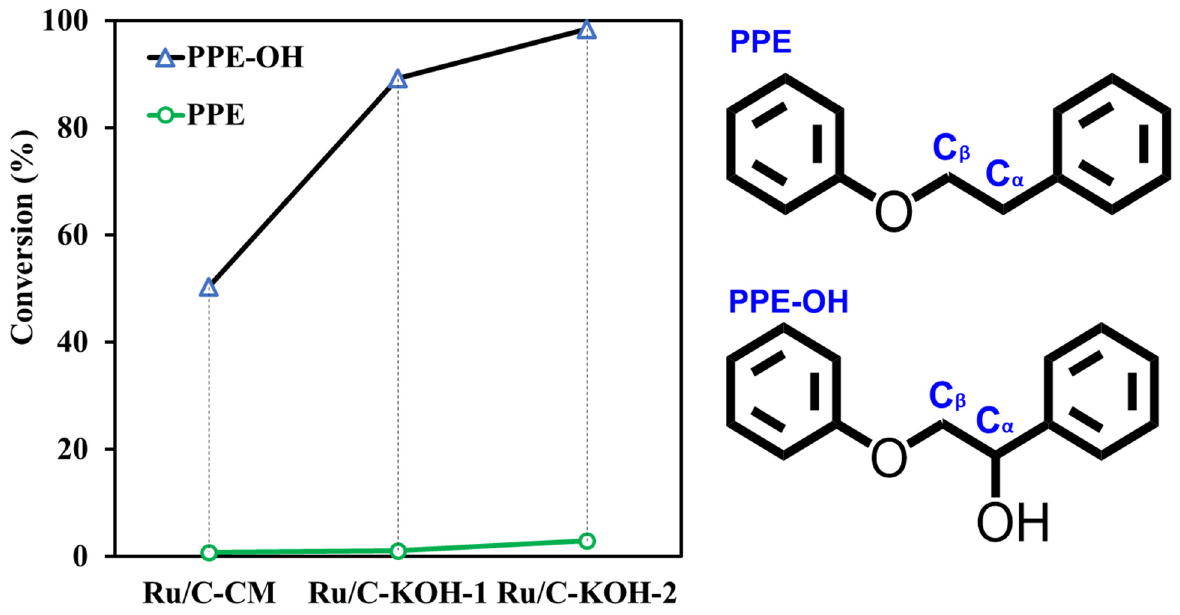
Figure 3. The conversion of 2-phenoxy-1-phenyl ethanol and 2-phenethyl phenyl ether over investigated Ru/C catalysts. Reaction conditions: 1 h, N 2 atmosphere, 1 wt.% reactant/ethanol, 20 wt.% catalyst loading.